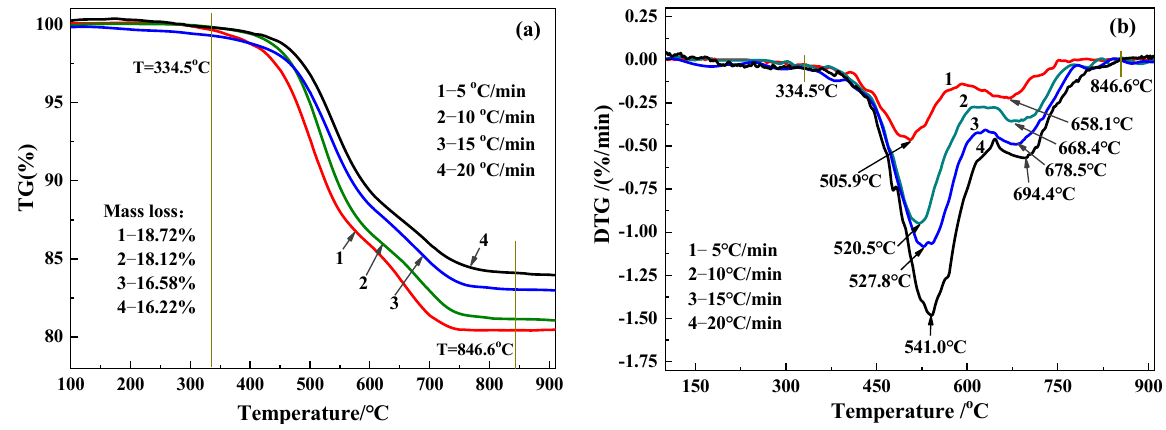
Figure 3. Thermal analysis of ( a) TG and ( b ) DTG curves of CSK. As shown in Figure 3a,b, the mass loss of TG from CSK started at ~334 °C and ended at 846 °C, with the mass loss ranging from 16.22% to 18.72%. The appearance of two peaks on the DTG curve indicated that the reaction contained two phases, and the area of the left peak was approximately twice that of the right peak. The overlapping of the two peaks indicated that the calcination of CSK was a complex reaction and the two phases cannot be separated.